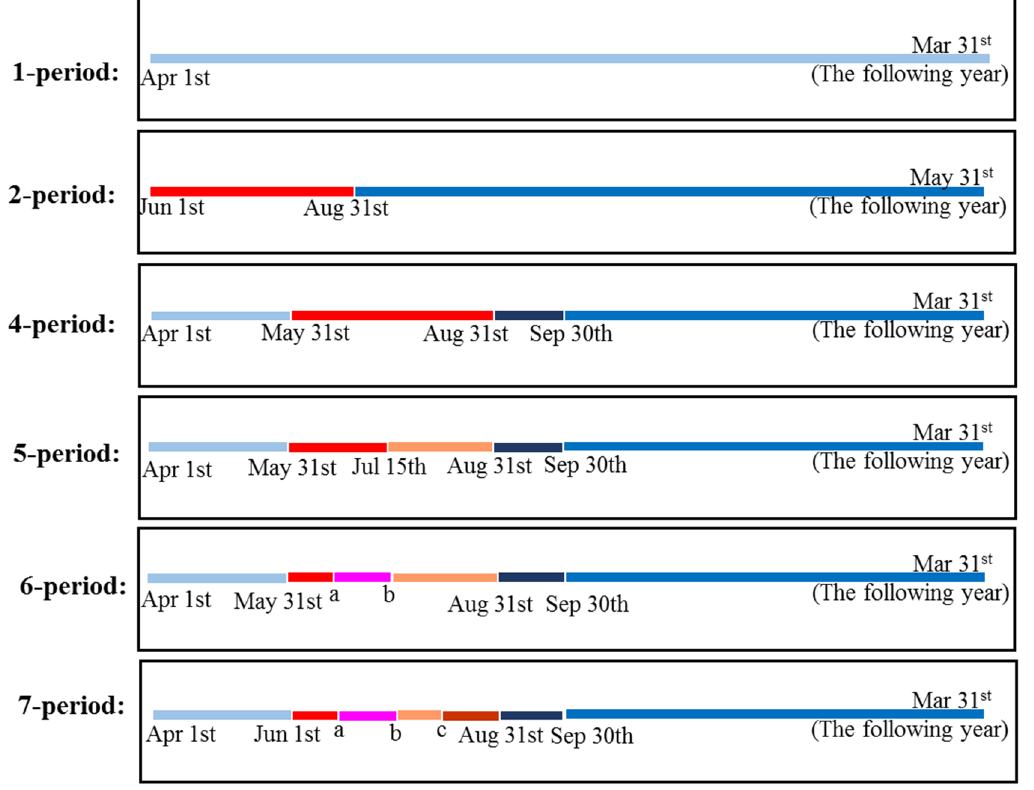
Figure 4. The beginning and ending dates of each period in a hydrological year for different calibration strategies. Each color in each calibration strategy represents a sub-period. For example, there are 2 sub-periods in the 2-period calibration, the 1st period is June 1 August 31 and the 2 period is September 1 May 31. a represents June 20, b represents July 15 and c represents August 5.